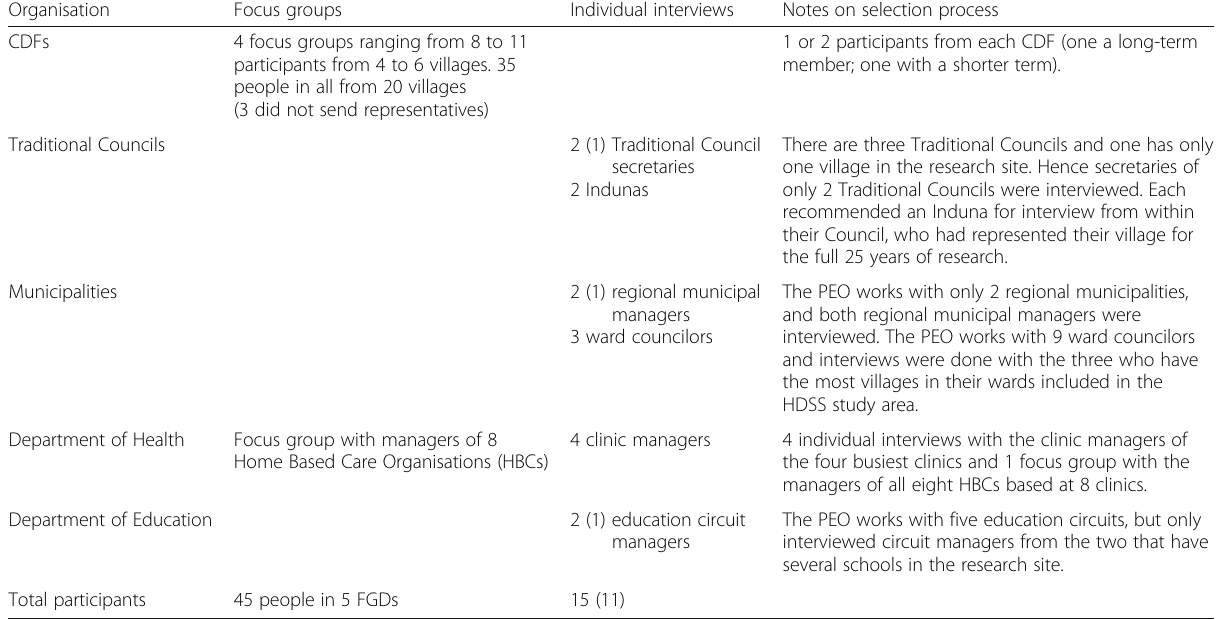
Table 1 Sample size and criteria for focus groups and